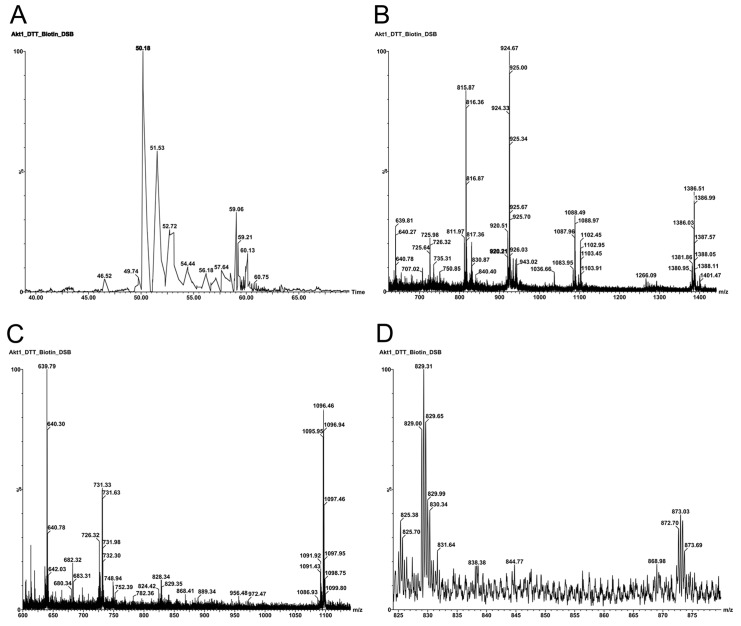
Mapping of cysteine residues in inactive Akt1/PKBα. (A) Base peak intensity (BPI) nano-LC chromatogram of affinity capture of all seven cysteine residues that were biotinylated with Iodoacetyl-LC-Biotin. Sample preparation: see materials and methods section for details. Column conditions: 75 mm ID ×150 mm, C18 PepMap300, 5 mm, under linear gradient conditions at a flow rate 95 nl/min. (B) TOF MS analysis of parent ions co-eluted at retention time of ∼53 min. Parent ions m/z 924.67 and 1386.51 are triply and doubly charged ions from the same tryptic peptide 308TFCGTPEYLAPEVLEDNDYGR328 which contains Cys310. Parent ion m/z 1266.09 is a triply charged ion from the tryptic peptide, 437YFDEEFTAQMTITPPDQDDSMECVDSER465, which contains Cys460. Parent ion m/z 815.87 is a doubly charged ion derived from the tryptic peptide, 77CLQWTTVIER86, which contains Cys77. The parent ion at m/z 1088.49 results from CH4 neutral loss from m/z 1096.46 as shown in C. (C) TOF MS analysis of parent ions co-eluting at retention time of ∼50.8 min. Parent ions m/z 731.33 and 1096.46 are triply and doubly charged ions from the same tryptic peptide, 49ESPLNNFSVAQCQLMK64, which contains Cys60. Parent ion m/z 639.79 is doubly charged and is derived from tryptic peptide, 290ITDFGLCK297, which contains Cys296. (D) TOF MS analysis of parent ions co-eluting at retention time of ∼53.5 min. Parent ion m/z 829.00 is triply charged and derived from tryptic peptide, 329AVDWWGLGVVMYEMMCGR346, which contains Cys344. Parent ion m/z 872.70 is triply charged and derived from tryptic peptide, 223LCFVMEYANGGELFFHLSR241, which contains Cys224.